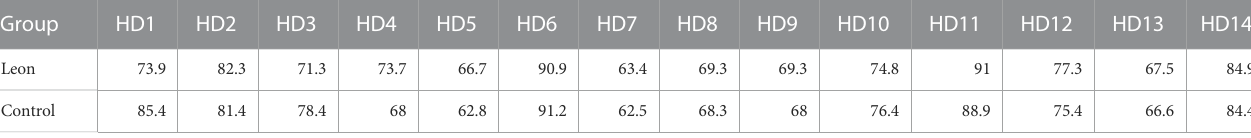
TABLE 2 The proportion of moDCs in the harvested cells (%) (HD-moDCs, n = 14). Group